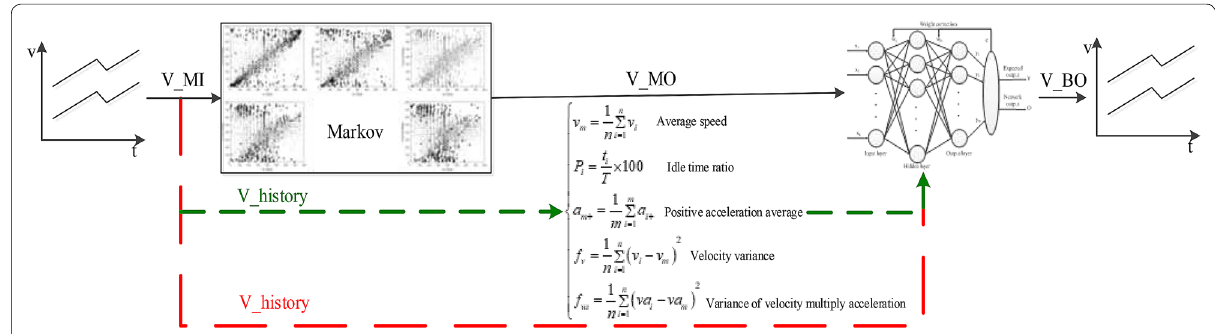
Figure 10 MBNN3 combined prediction